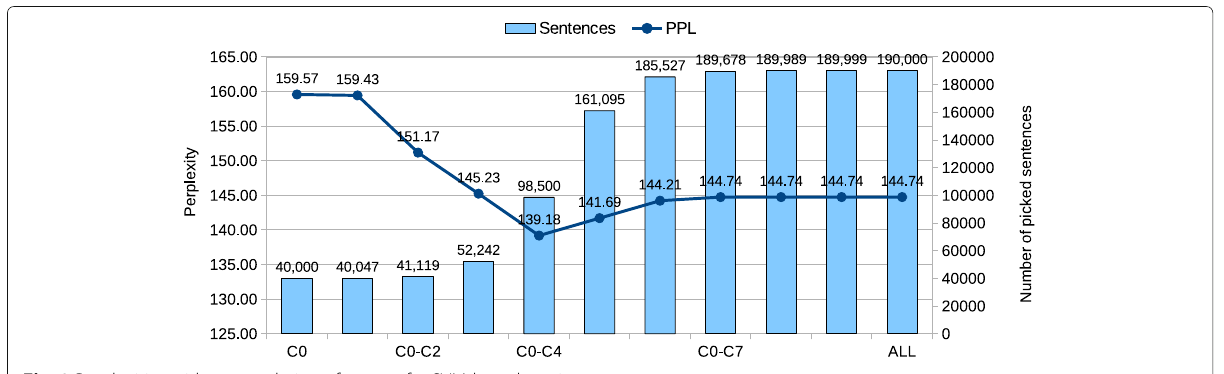
for CRF, the perplexity is the minimum. These accumu- lated groups, containing totally 98K sentences for SVM and 174K sentences for CRF, are regarded as the optimal clusters.